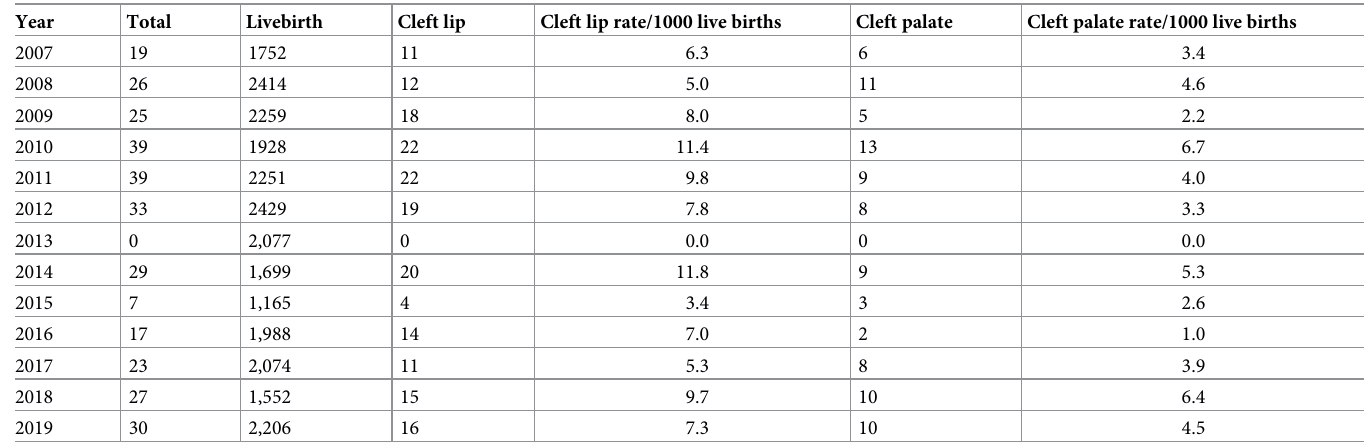
Table 2. Trends in the annual number of clefts and incidence (2007–2019).